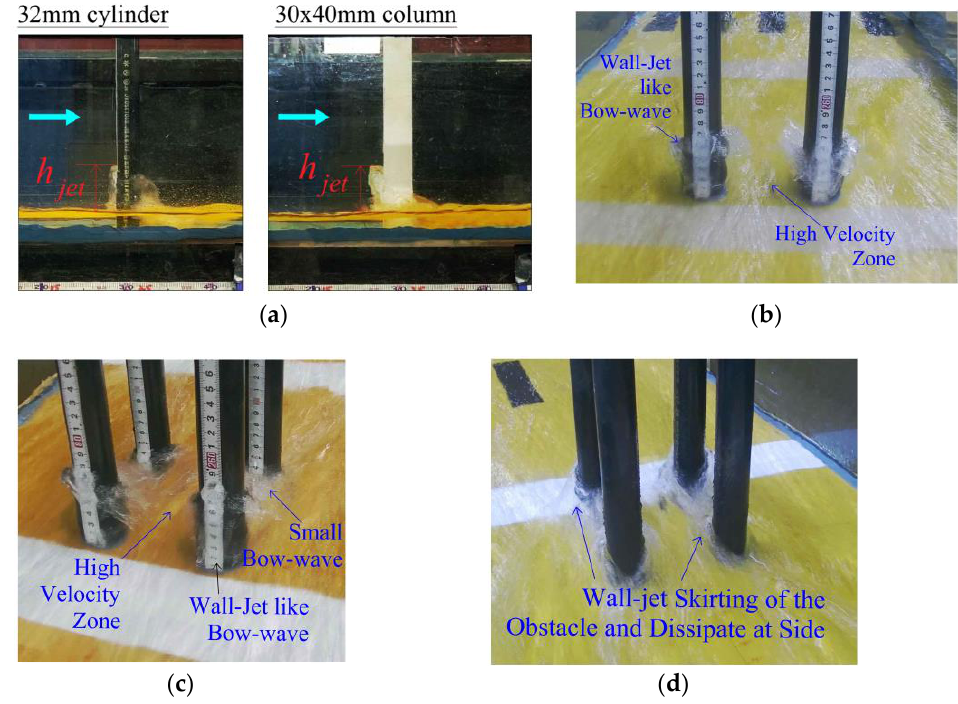
Figure 6. Formation of the wall - jet - like bow - wave for the supercritical flow on the horizontal channel bed: ( a ) wall - jet in case C1, ( b ) front view of case C2 - 1, ( c ) front view of case C4 - 1, ( d ) back view of case C4 - 1. Table 6. Non-dimensional wall-jet height h ∗ ( = h jet / h o ) relative to the upstream water depth ( h o ) jet for the supercritical flow over the horizontal channel bed for case